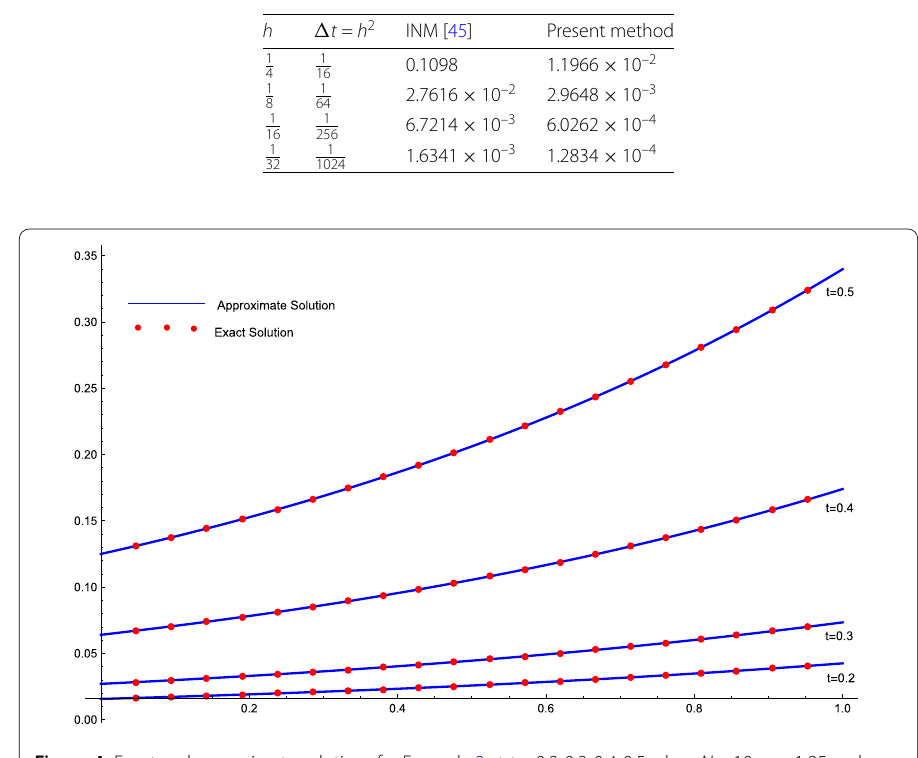
Figure 4 Exact and approximate solutions for Example 2 at t = 0.2,0.3,0.4,0.5 when N = 10, α = 1.85 and (cid:11) t = 0.001